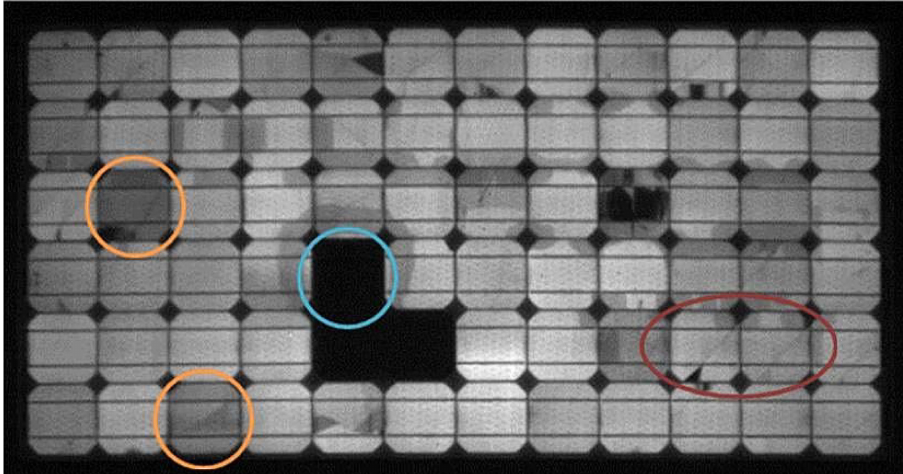
Figure 10. EL image of the 0.5 A PV panel (10% I sc ) in the pilot plant. Capture made with the camera fixed on a tripod.